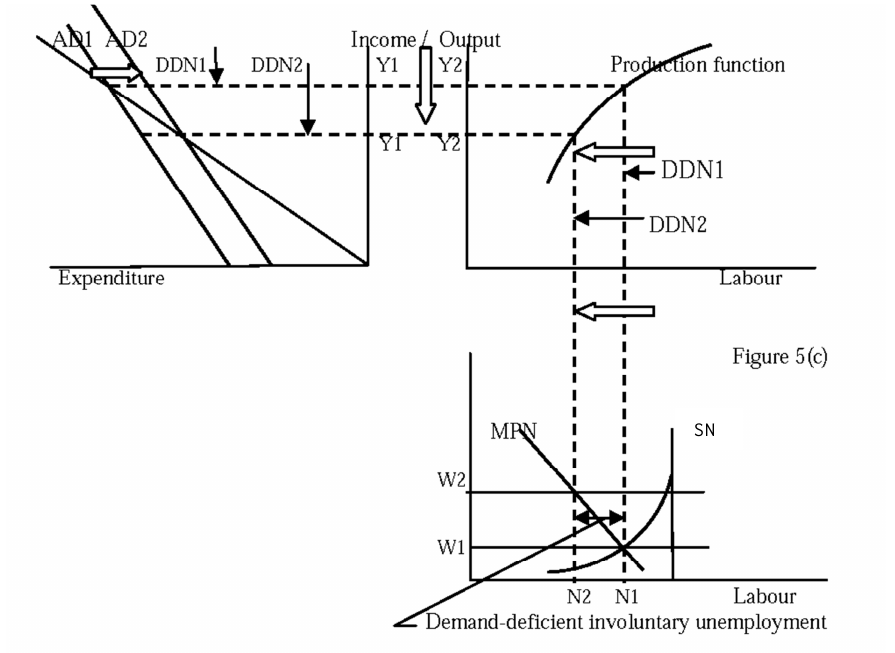
Source: Lange (1944, p. 6), Davar (2016, p. 616). Figure 5. The derived demand for labour function (DDN) – (shown - - - -) and involuntary